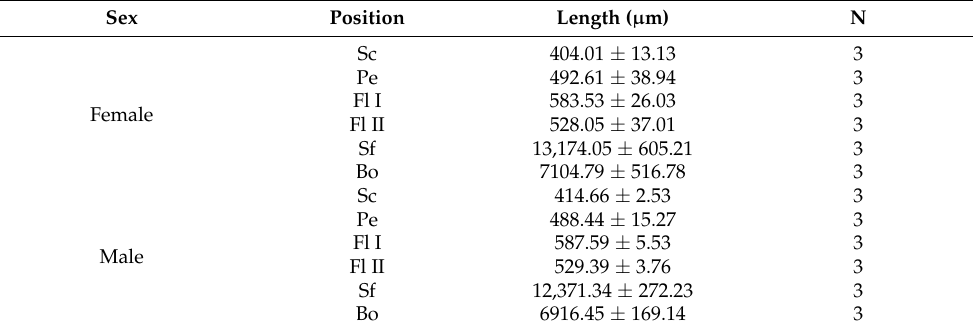
Table 1. Measurements of Mezira yunnana (mean ±